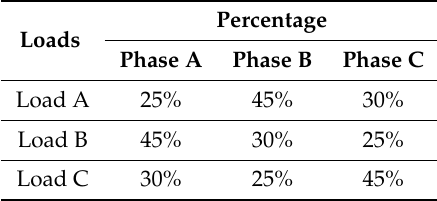
Table 2. Form “A” of the load by phase distribution.